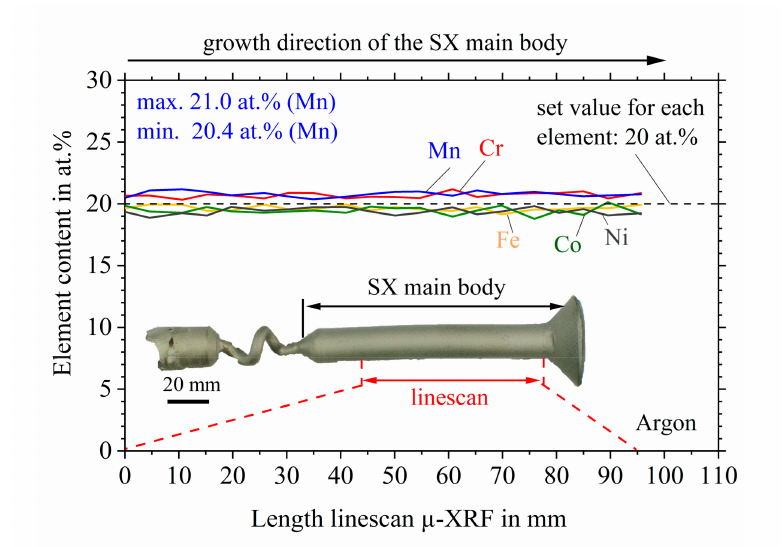
Figure 1. Elemental concentration of the SX-CrMnFeCoNi alloy measured with µ -XRF cast in argon